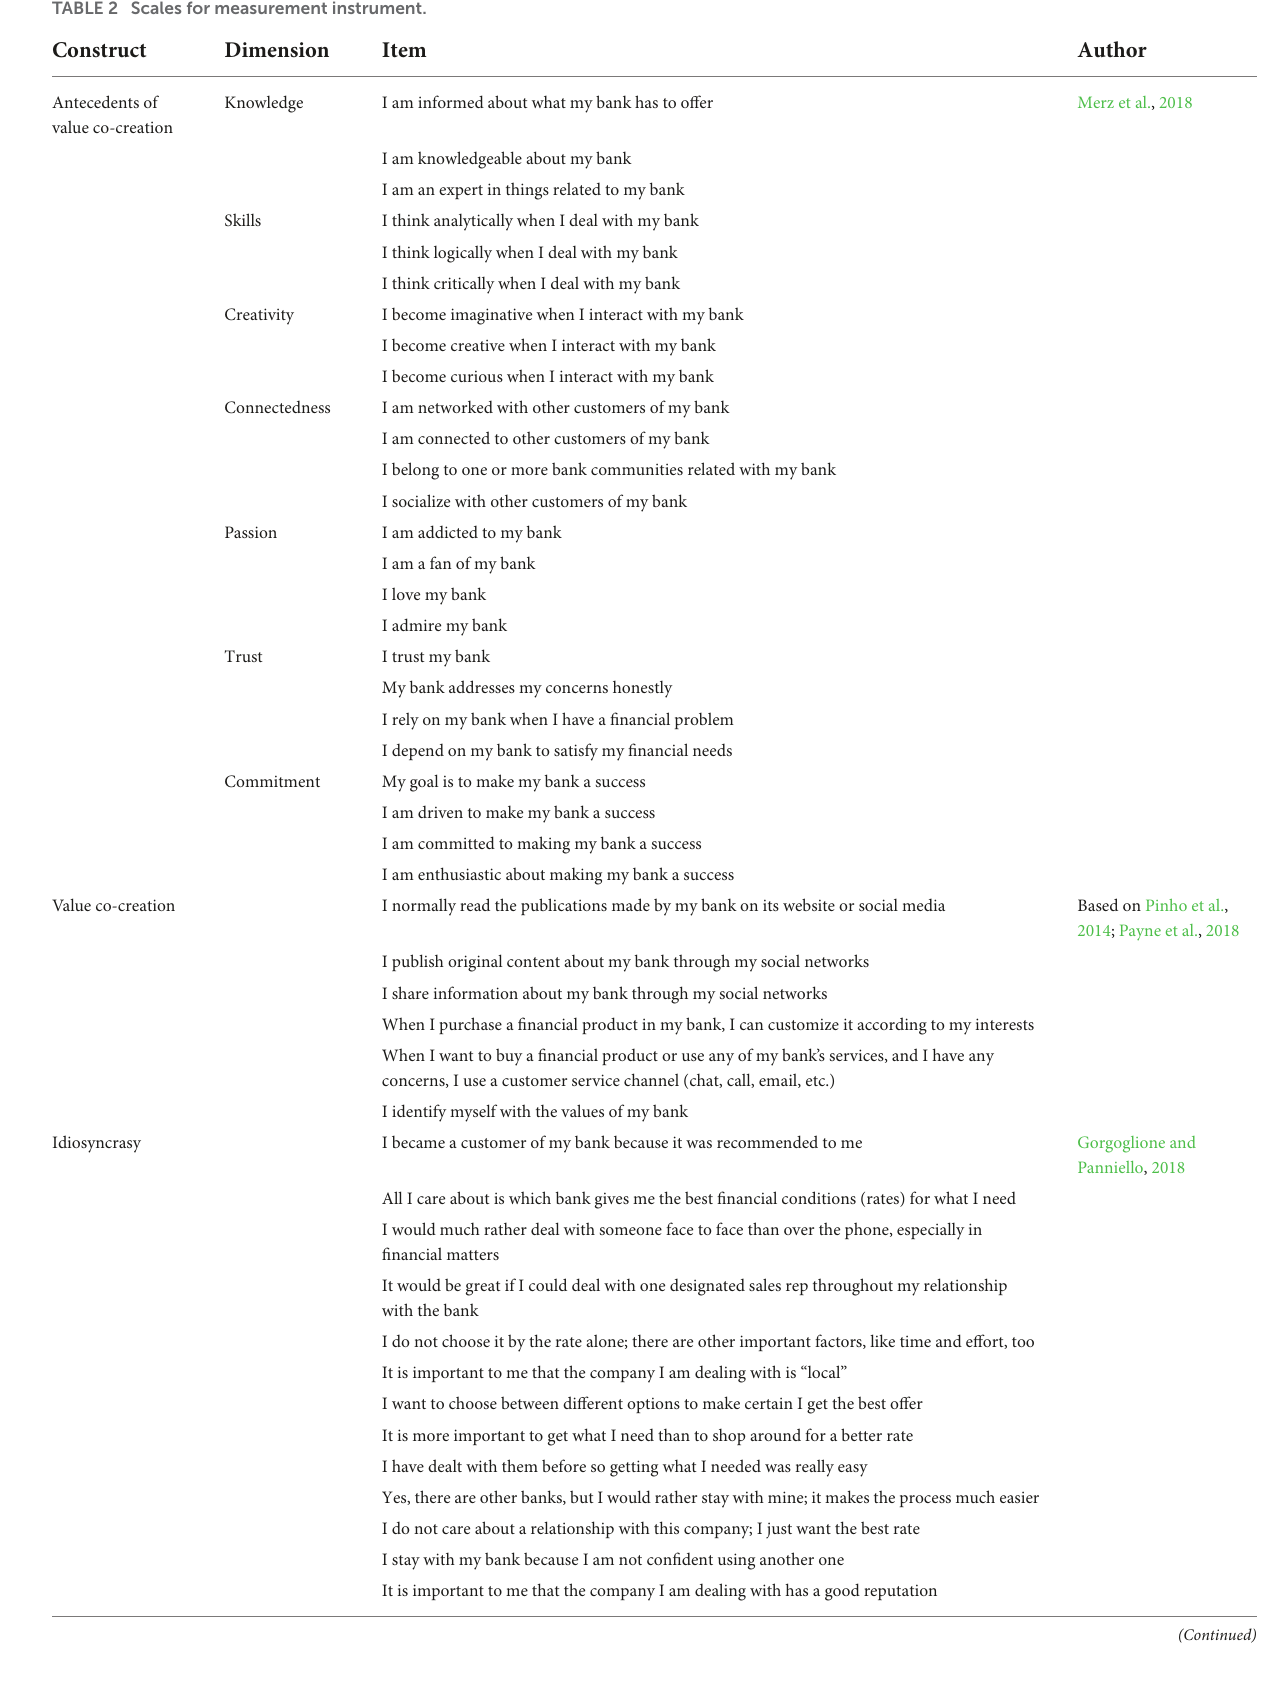
TABLE 2 Scales for measurement